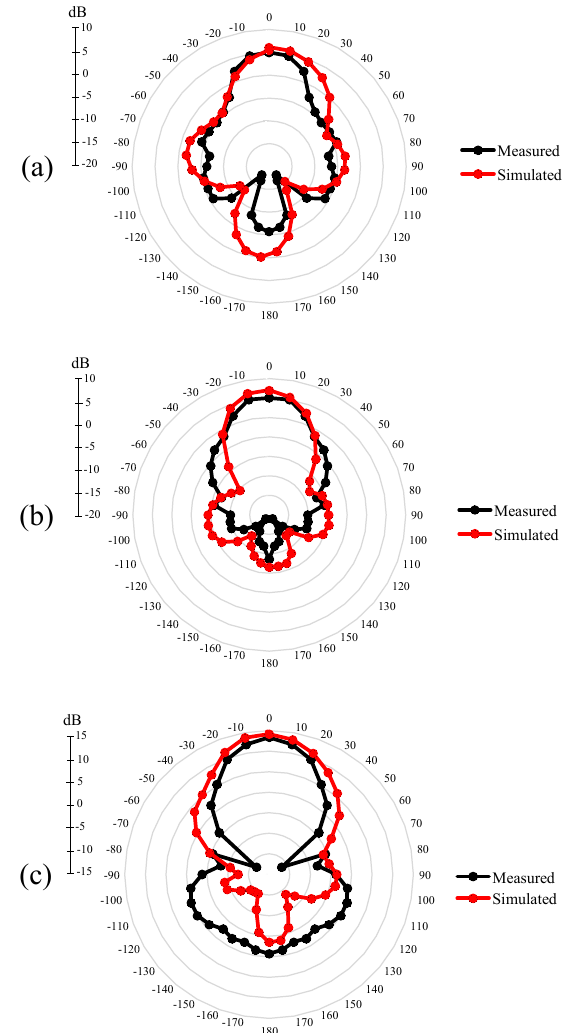
Figure 11. 2D—Normalized radiation patterns at ( a ) 23 GHz, ( b ) 28 GHz, and ( c ) 30 GHz from sim- ulation and measurement.